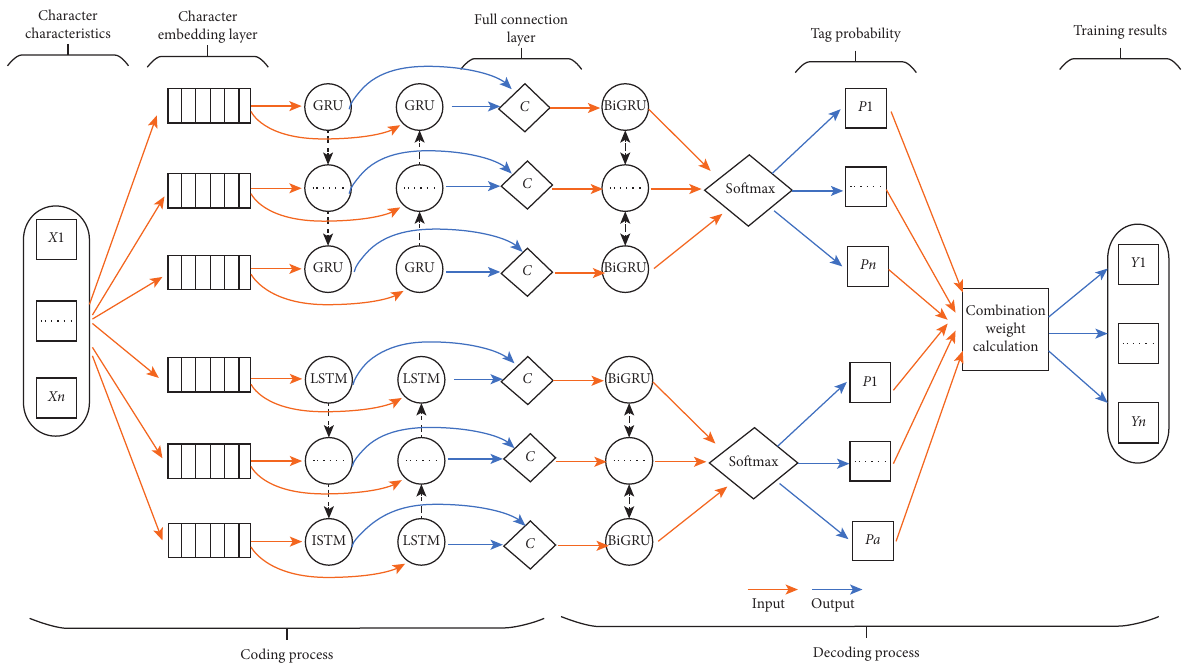
Figure 4: The network structure of the stacking single-layer classification